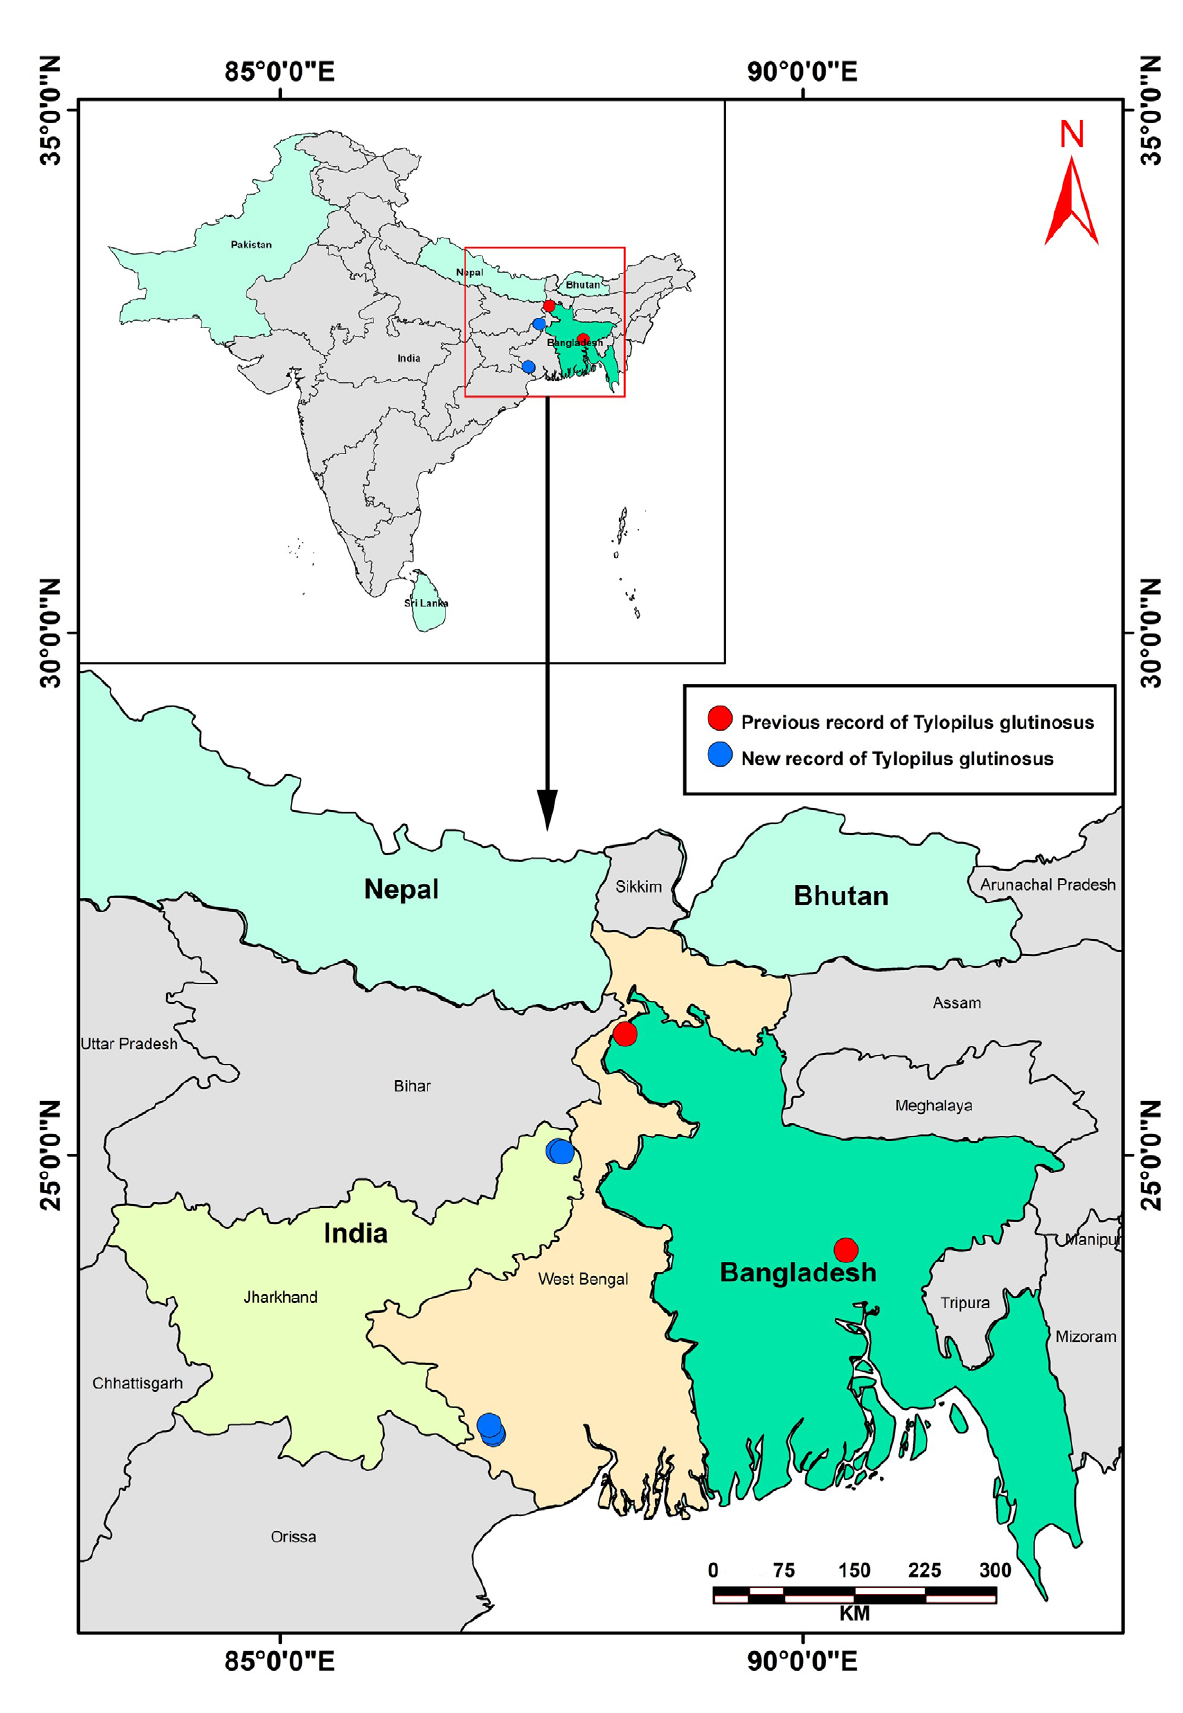
Figure 1. Geographic distribution of Tylopilus glutinosus : first collections records (red circle) from Bangladesh and new records in India (blue